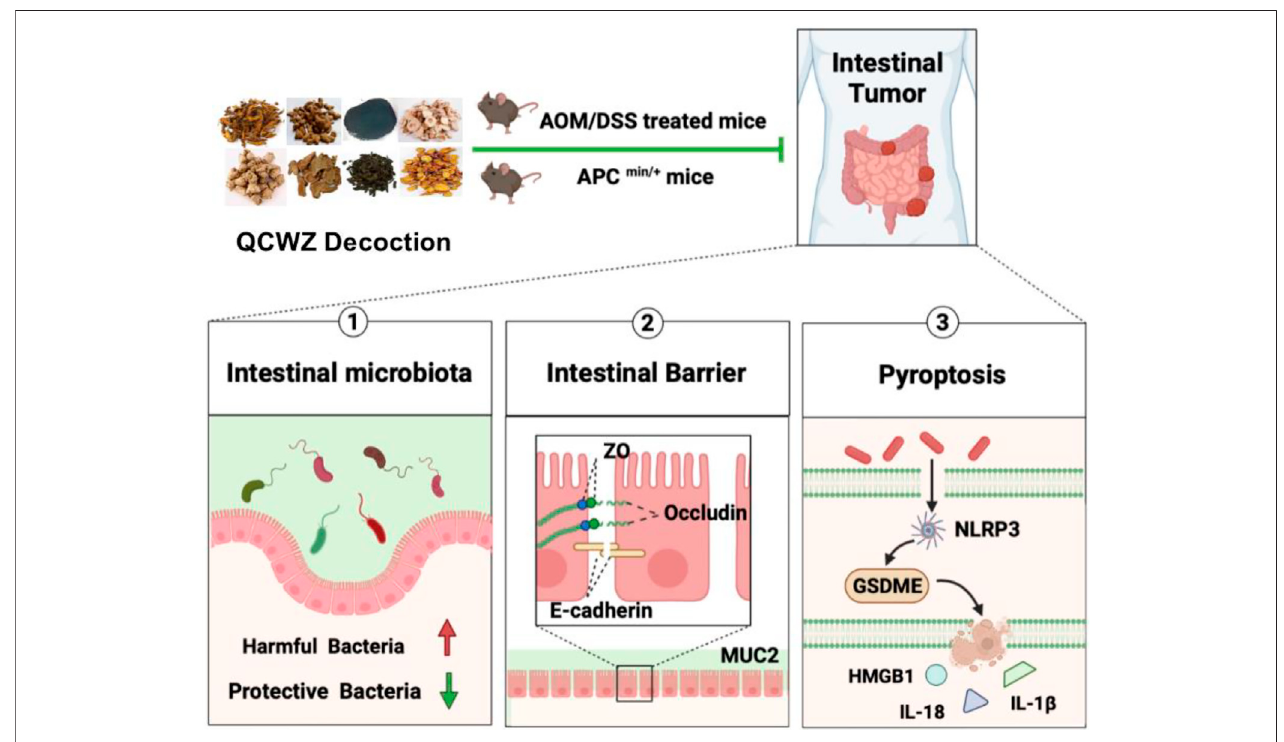
FIGURE 9 | Schematic diagram of how QCWZD prevents intestinal